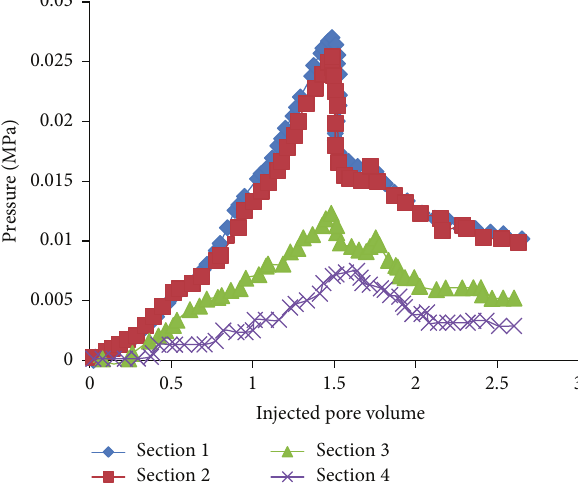
Figure 15: The plot of the injection pressure (diameter: 0.08– 0.1mm, concentration: 1000 mg/L).